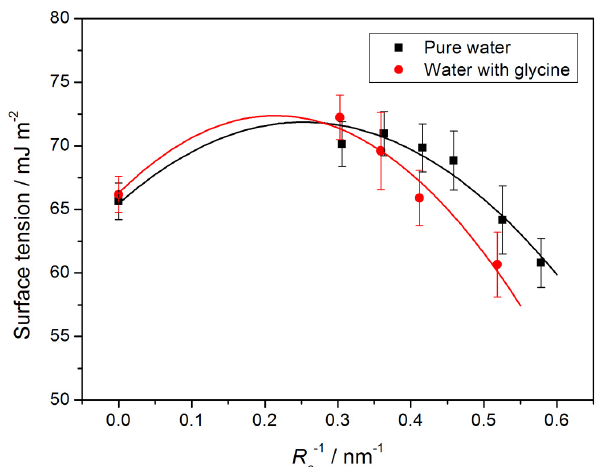
Fig. 5. Curvature dependence of surface tension of pure water and glycine-water mixture.